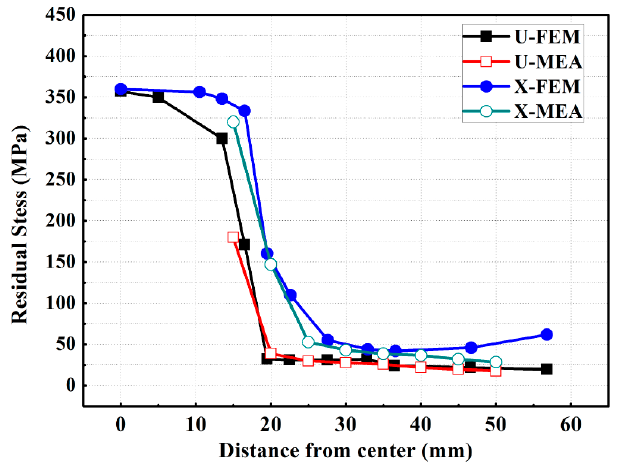
Figure 10. Results of measuring and predicting of the residual stress distribution.